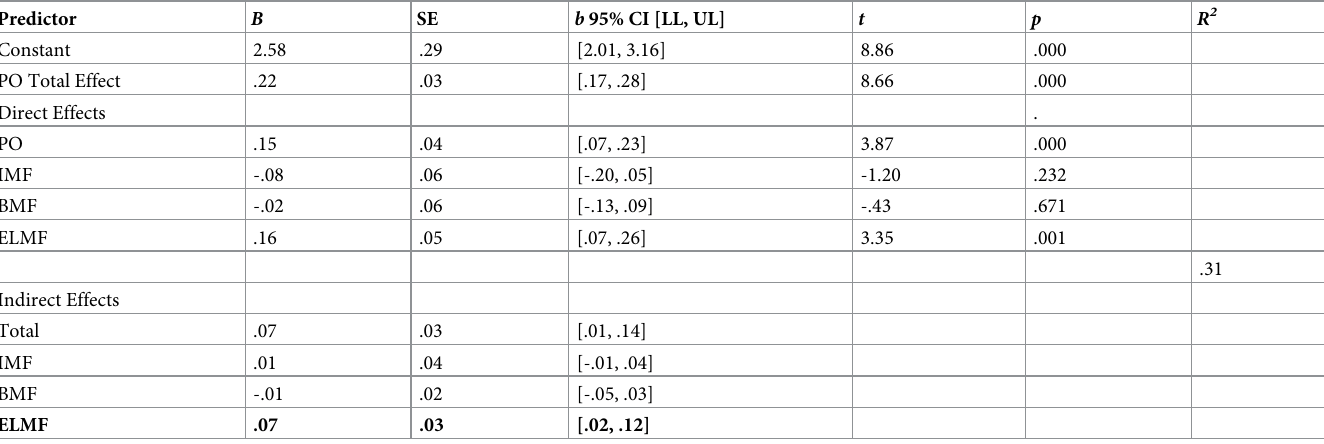
Table 14. Mediation effects of moral foundations on the relationship between political orientation and government overreaction scale (N = 209). Predictor